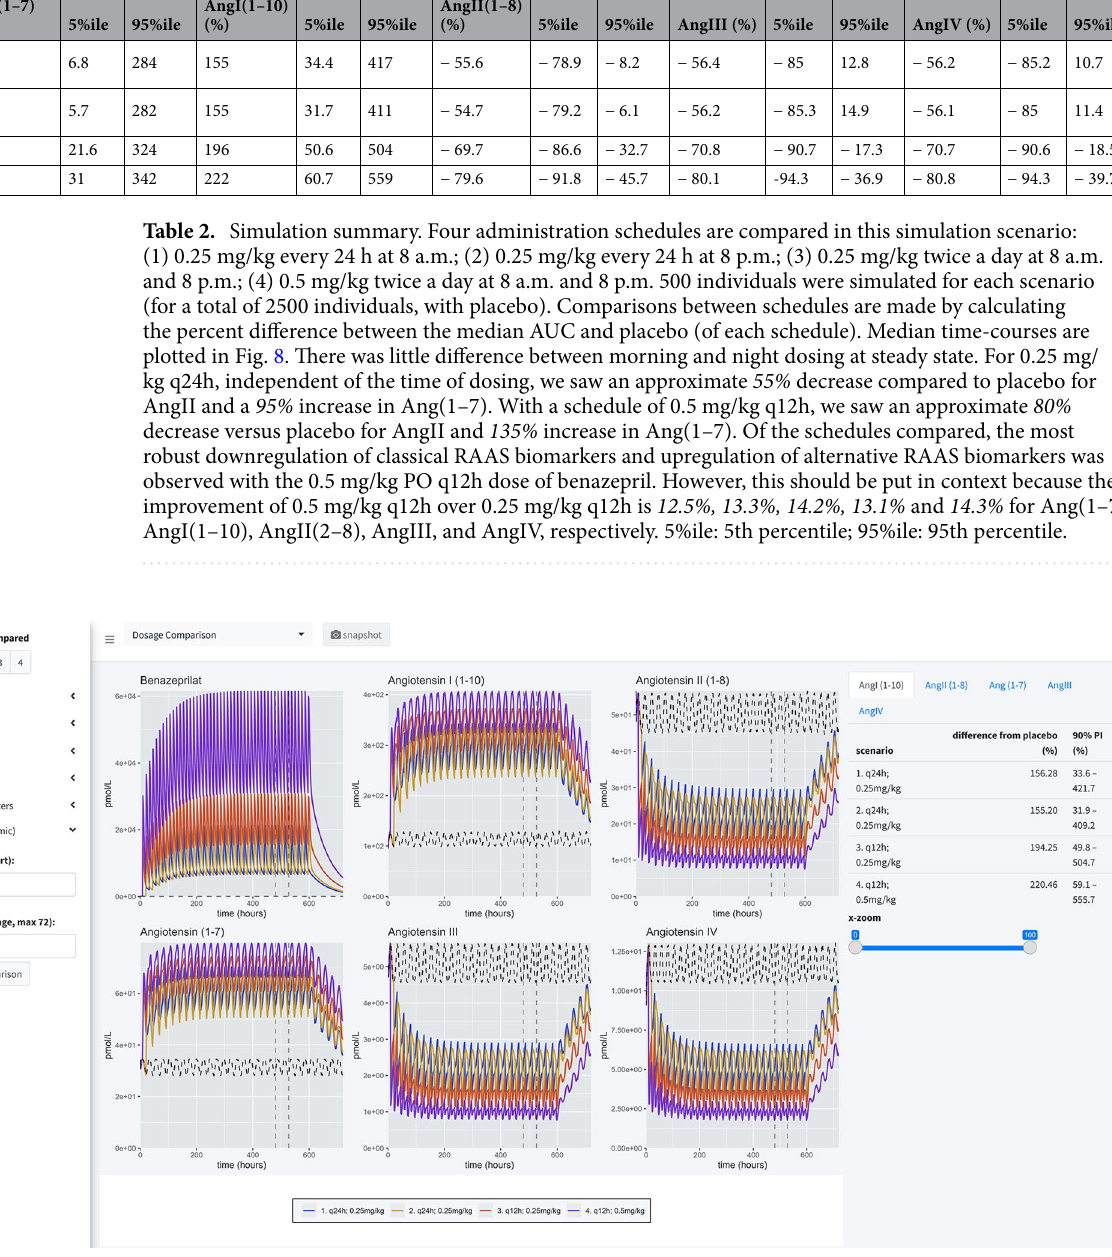
Figure 8. Simulation summary. Four administration schedules are compared in this simulation scenario: (1) 0.25 mg/kg every 24 h at 8 a.m.; (2) 0.25 mg/kg every 24 h at 8 p.m.; (3) 0.25 mg/kg twice a day at 8 a.m. and 8 p.m.; (4) 0.5 mg/kg twice a day at 8 a.m. and 8 p.m. 500 individuals were simulated for each scenario (for a total of 2500 individuals, with placebo). Curves are the median time-course of the molecule from this